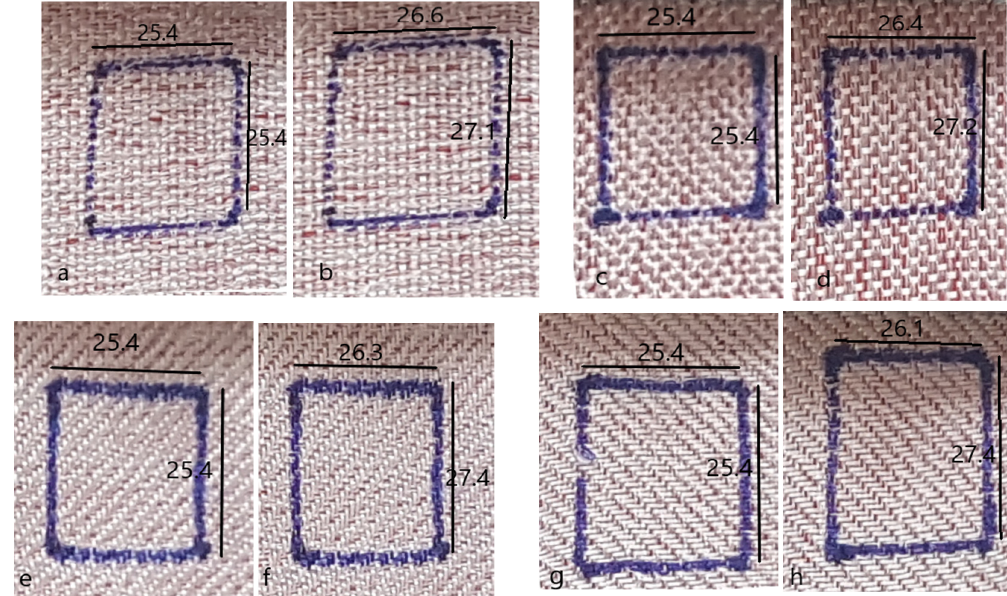
Figure 8. Changes in longitudinal and lateral directions for all fabrics samples. ( a , b ) Matt warp, ( c , d ) matt weft, ( e , f ) twill weft, and ( g , h ) twill weft.